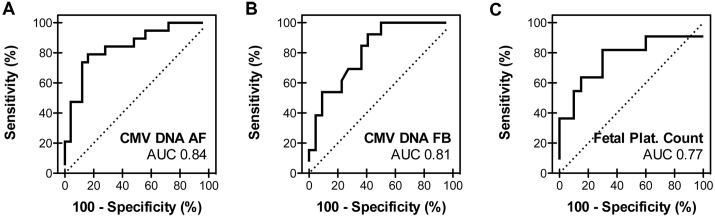
Performance of other frequently used parameters in the validation cohort.ROC curves for CMV DNA levels in amniotic fluid (A) and fetal blood (B) and the fetal platelet count (C) in the combined discovery and validation cohort. AF, amniotic fluid; FB, fetal blood; Plat., platelet.